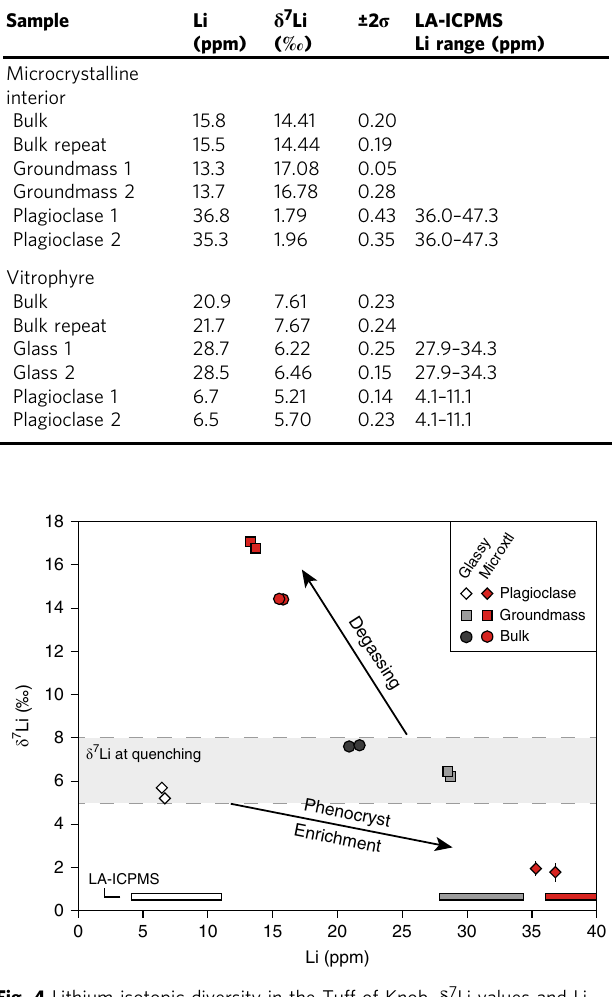
Fig. 4 Lithium isotopic diversity in the Tuff of Knob. δ 7 Li values and Li abundances in bulk, groundmass and plagioclase from the Tuff of Knob vary as a function of cooling rate. Coloured bars along the abscissa indicate the total ranges of Li measured in situ in the respective phases